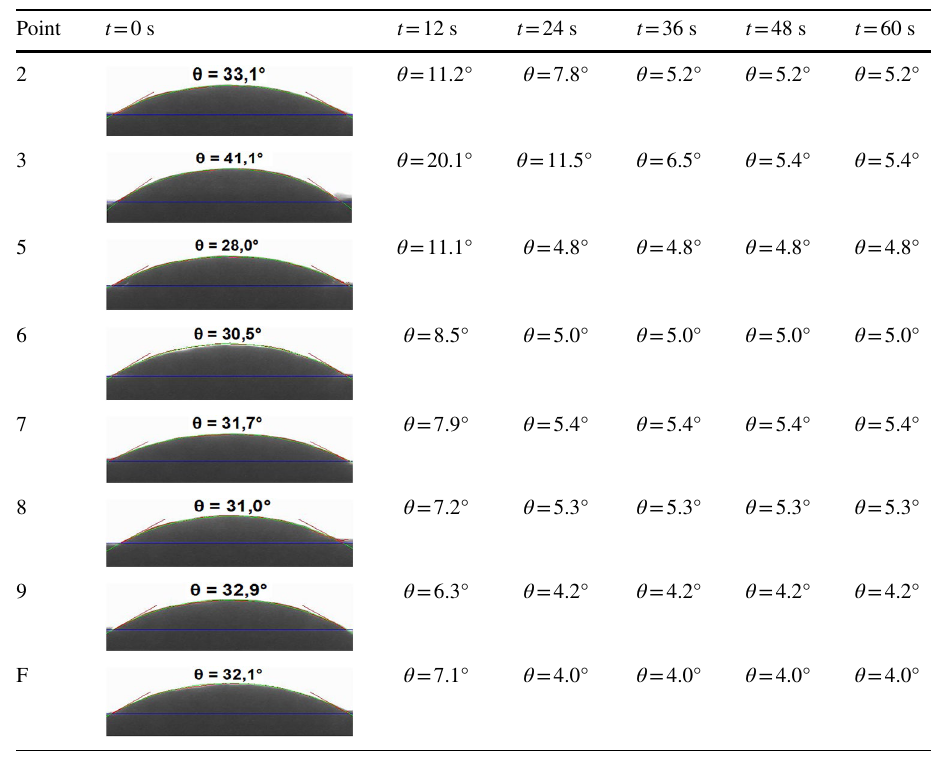
Table 5 Wettability test (contact angle) for points 2, 3, 5, 6, 7, 8, 9 and F